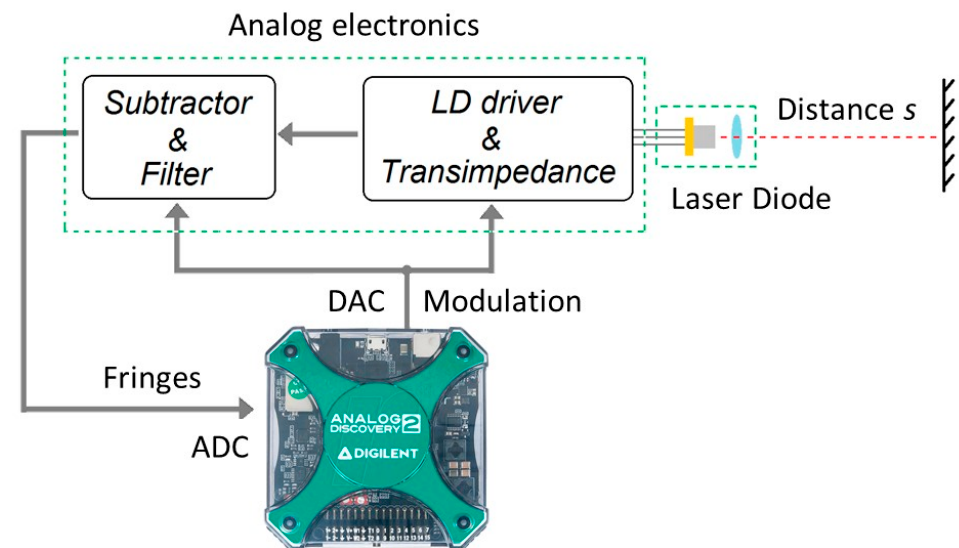
Figure 3. Block scheme of the self-mixing instrument.